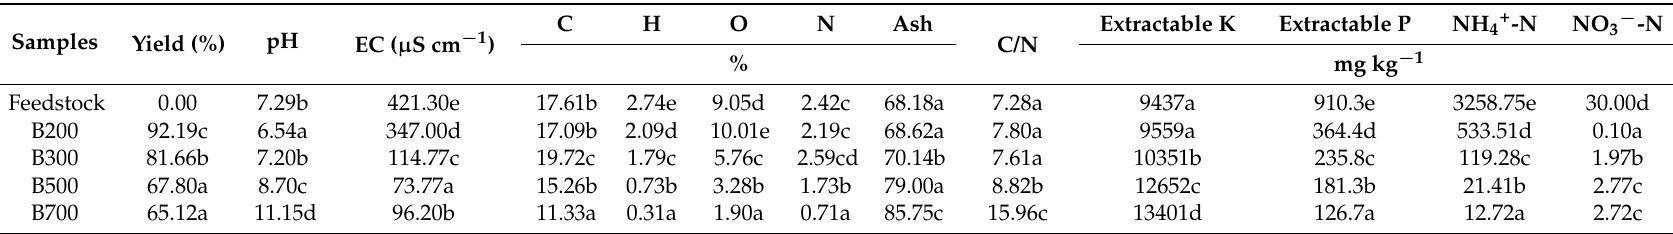
Table 1. The characteristics of municipal sewage sludge and their biochars produced at 200 ◦ C, 300 ◦ C, 500 ◦ C, and 700 ◦ C for 2 h in a muffle furnace.